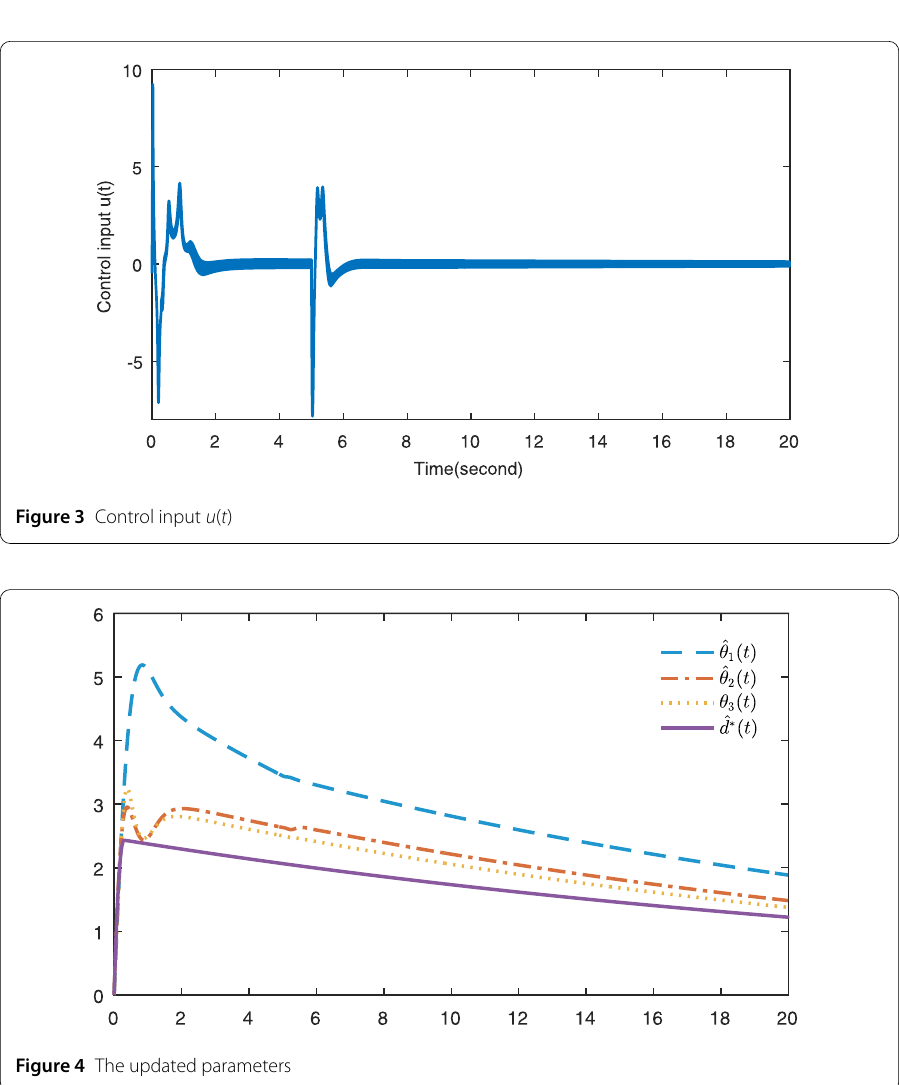
Figure 4 The updated